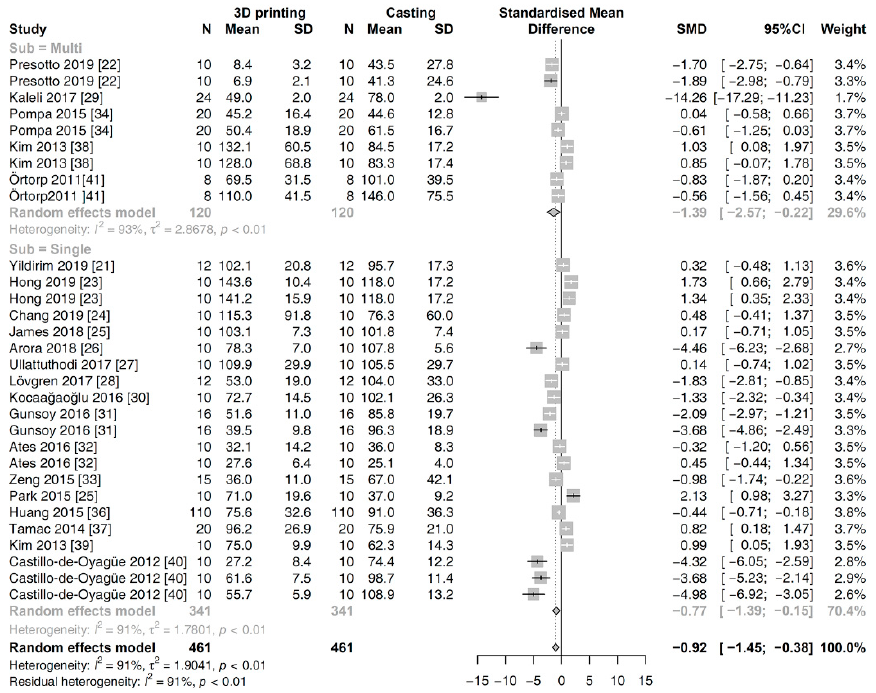
Figure 4. Subgroup meta-analysis for the different prosthesis types on the marginal gap between 3D printing and casting methods.